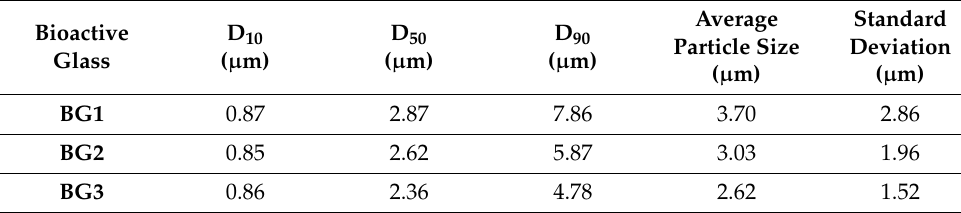
Table 2. Relevant particle size distribution data of the BG powder samples (BG1 – 3).